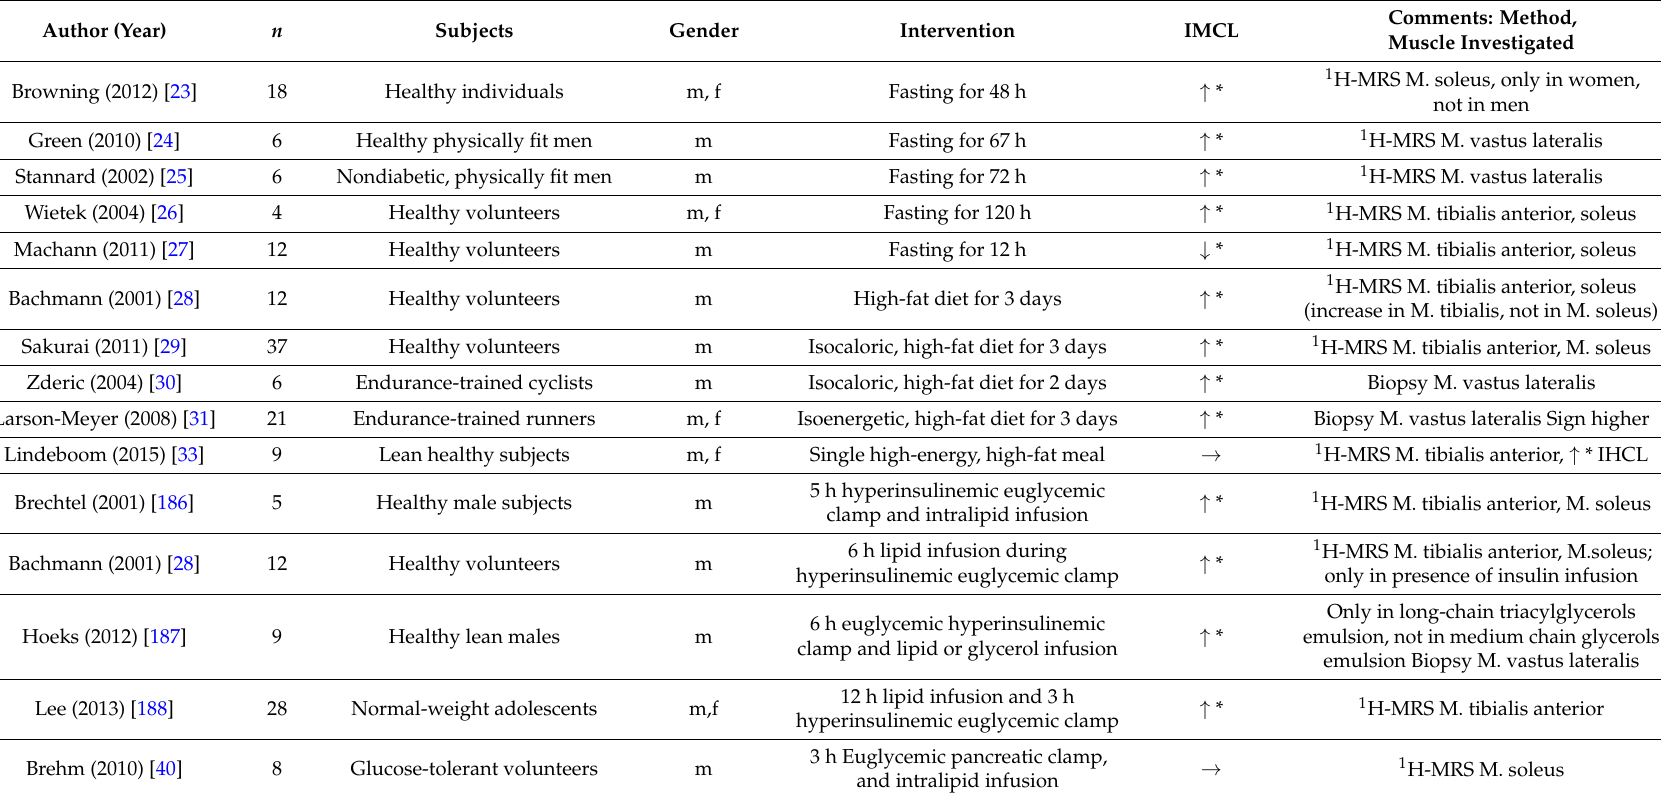
Table 3. Effect of short-term dietary interventions on